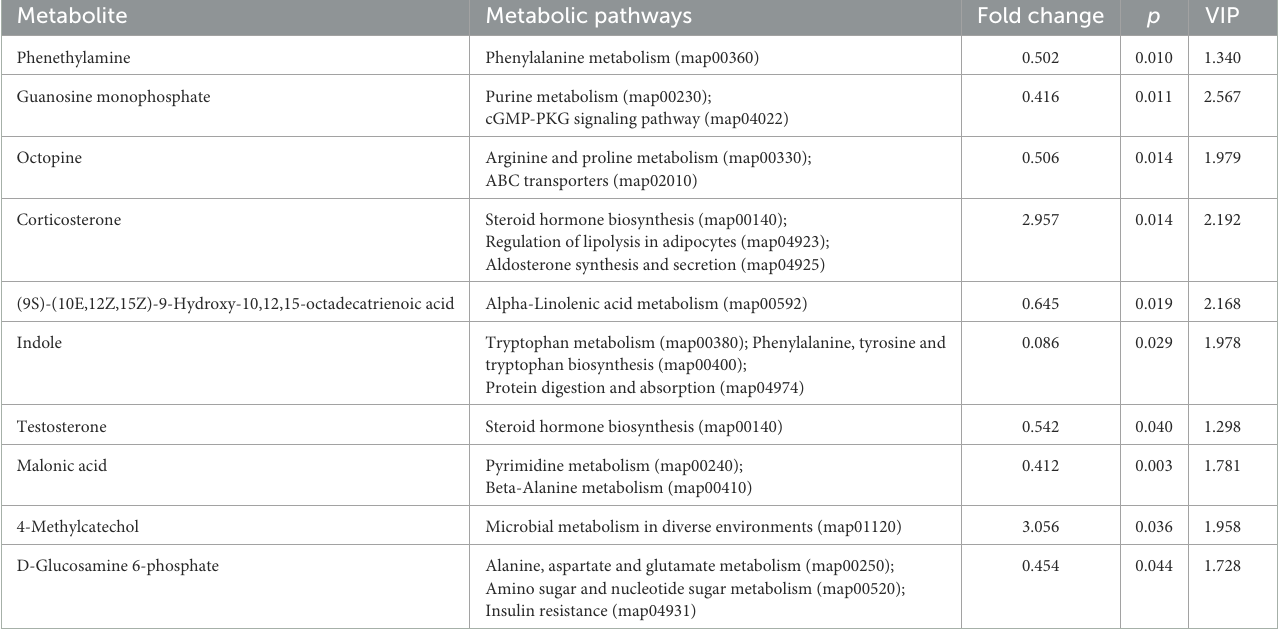
TABLE 7 Metabolites and their corresponding metabolic pathways (XS-XB).